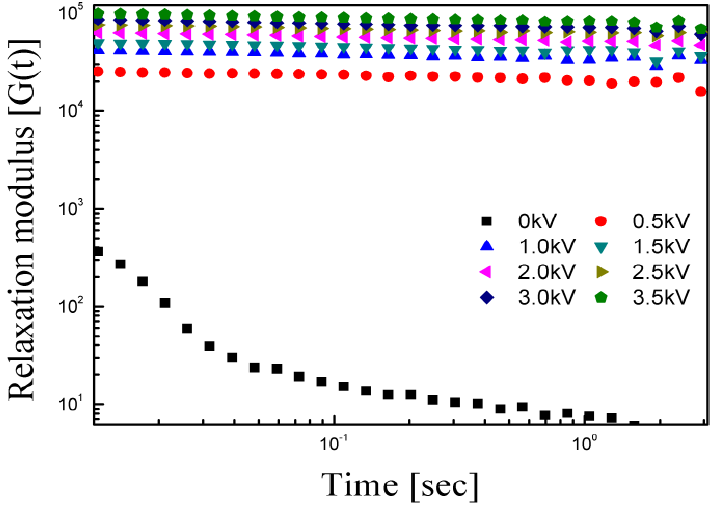
Figure 9. Relaxation modulus of the ER fluids calculated from G' and G''